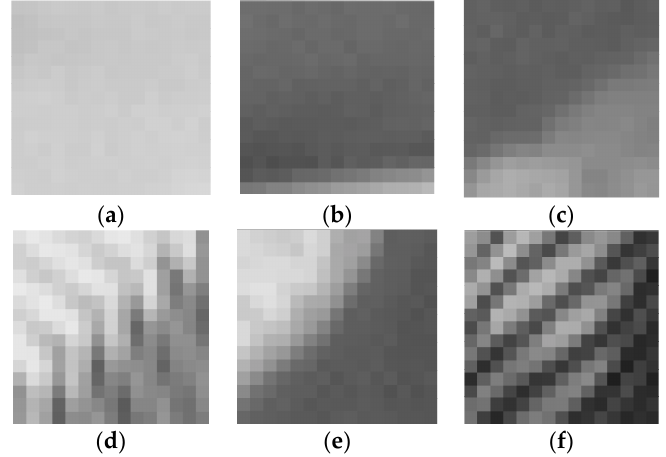
H of various noise-free image blocks, and weakly textured Figure 2. Local gray statistic entropy H Figure 2. Local gray statistic entropy le le of various noise-free image blocks, and weakly textured blocks have relatively bigger local gray statistic entropy (LGSE) values; ( a ) H le = 7.8135; ( b ) H le = 7.7972; ( c ) H le = 7.7761; ( d ) H le = 7.7618; ( e ) H le = 7.7158; ( f ) H le =